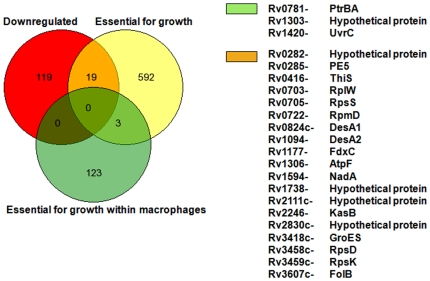
Comparison with Rubin's lists of genes that were found to be downregulated in microarray experiments.Red circle shows the genes upregulated; yellow and green circles show the genes essential for in vitro growth and for survival of mycobacteria within macrophages, respectively.